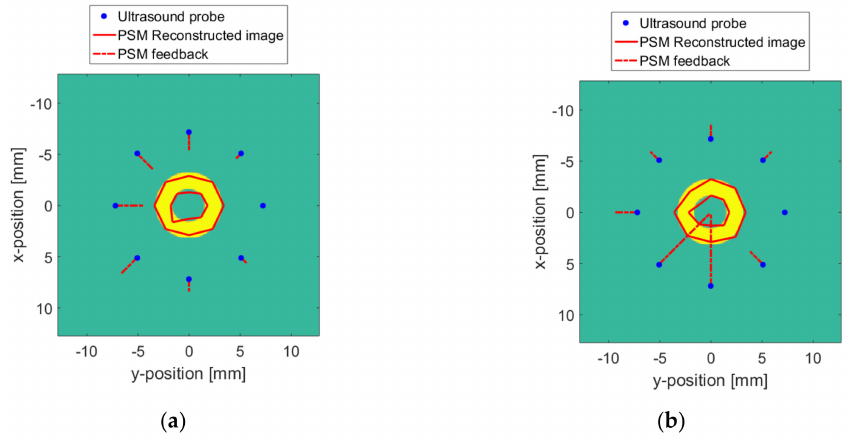
Figure 22. Reconstructed image with the PSM when ∆ v = 8: ( a ) With surface changes; ( b ) With TMC changes.